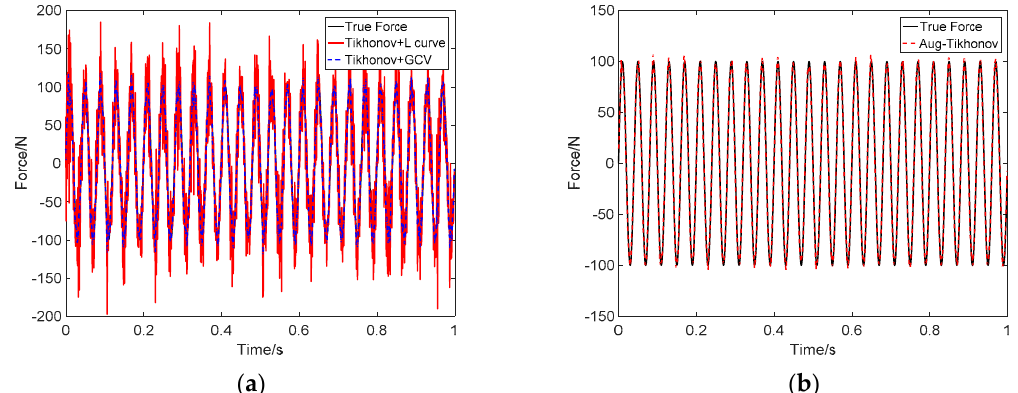
Figure 23. Unit impulse response diagram.